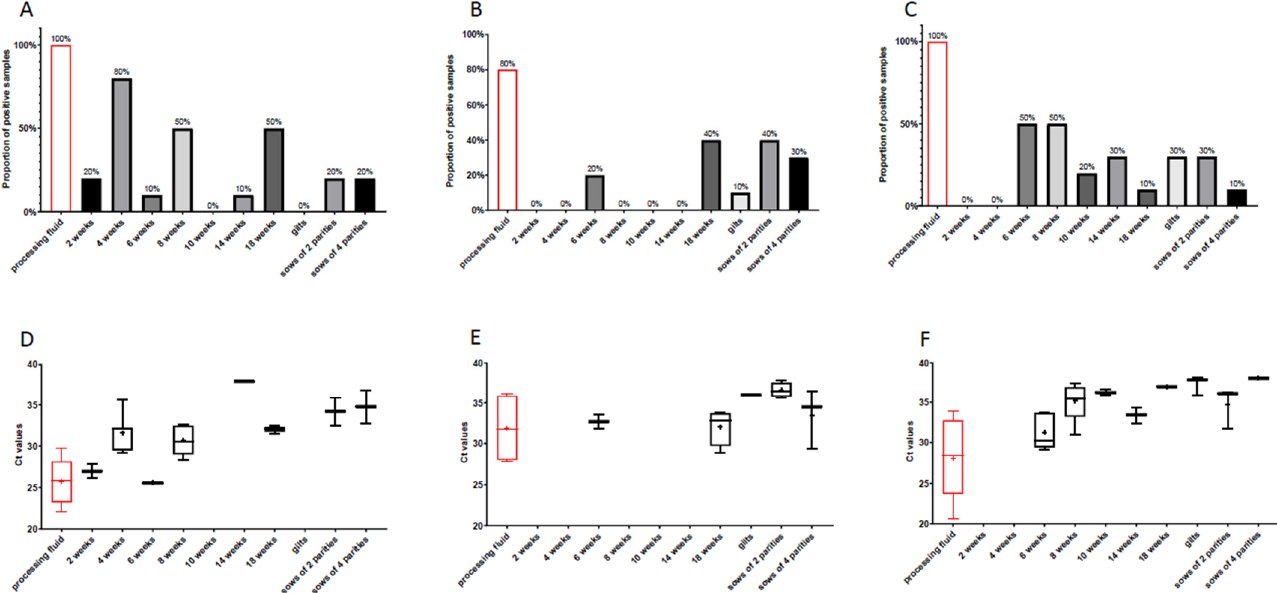
Figure 5. ( A – C ) Percentages of PCV3-positive processing fluid and serum samples of different age groups from Farm K ( A ), Farm JA ( B ) and Farm SZ ( C ). ( D – F ) Boxplots representing the Ct values of the PCV3-positive processing fluid and serum samples of different age groups from Farm K ( D ), Farm JA ( E ) and Farm SZ ( F ). The whiskers show the minimum and the maximum, and the ”+” signs represent the average. The horizontal lines of the box show the first quartile, the median and the third quartile.